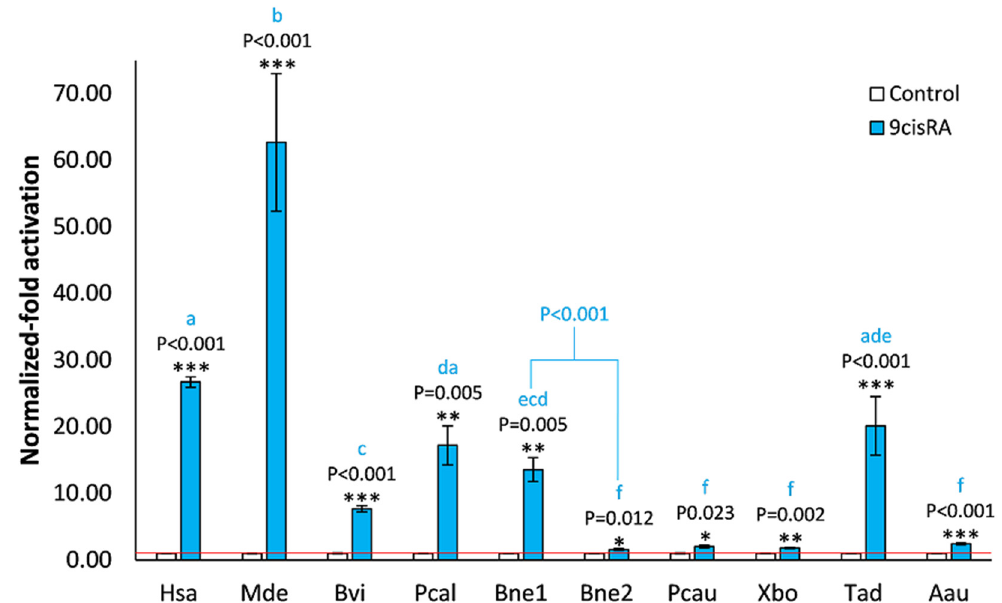
Figure 3. Transactivation activity of luciferase reporter gene mediated by GAL4 DNA-binding domain (DBD)–RXR LBD chimeric receptors in COS-1 cells in the presence of 9-cis retinoic acid (9cisRA). Data represent means ± SEM from three independent experiments (n = 3). The results were normalized to the control condition (DMSO without ligand). Significant di ff erences between 9cisRA and the solvent control were inferred with Student’s t-test. Asterisks denote significant di ff erences (* P ≤ 0.05, ** P ≤ 0.01, *** P ≤ 0.001). Significant di ff erences among the di ff erent RXRs in the test condition were inferred with one-way ANOVA (source of variation: F = 61.9, P < 0.001). The di ff erent letters